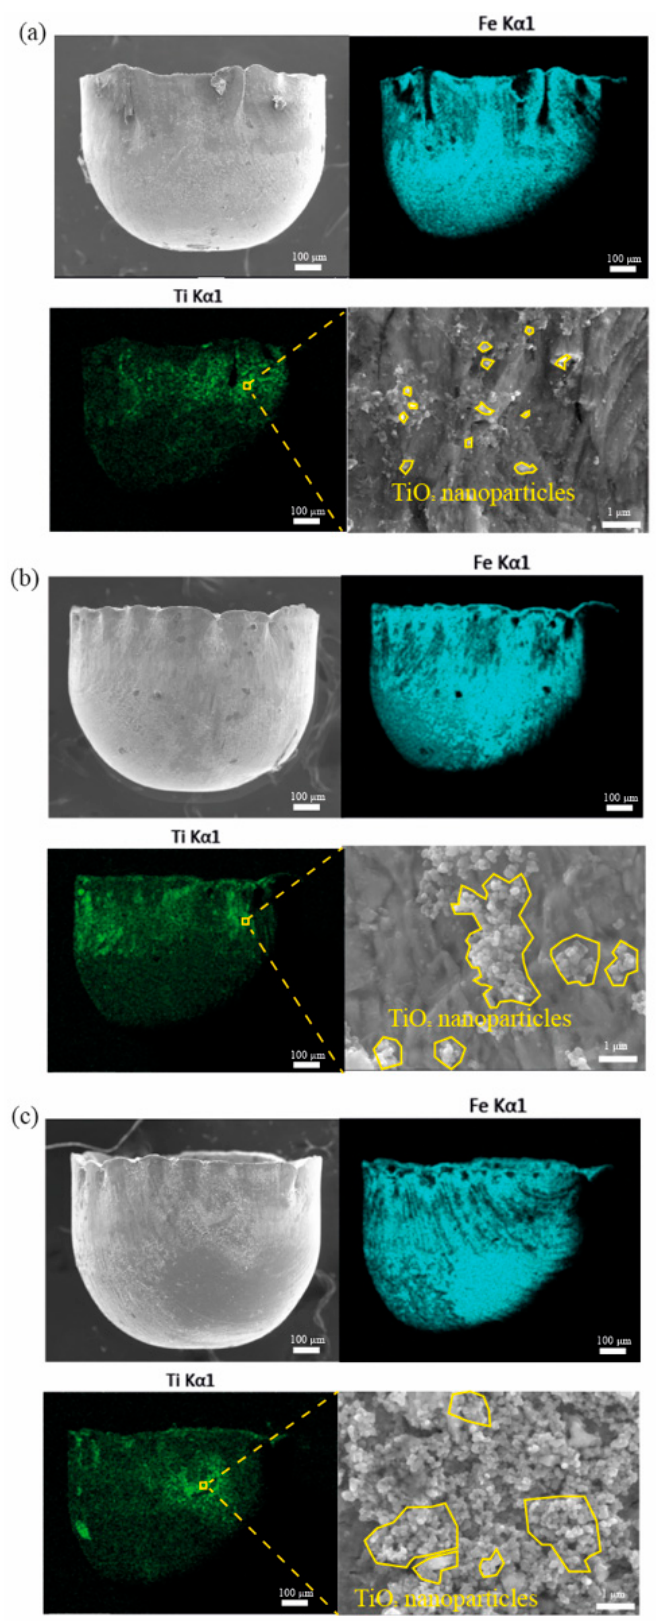
Figure 11. SEM images and EDS mappings of the micro cups surfaces lubricated by ( a ) 1 wt% TiO 2 nanolubricant, ( b ) 2 wt% TiO 2 nanolubricant, and ( c ) 4 wt% TiO 2 nanolubricant.